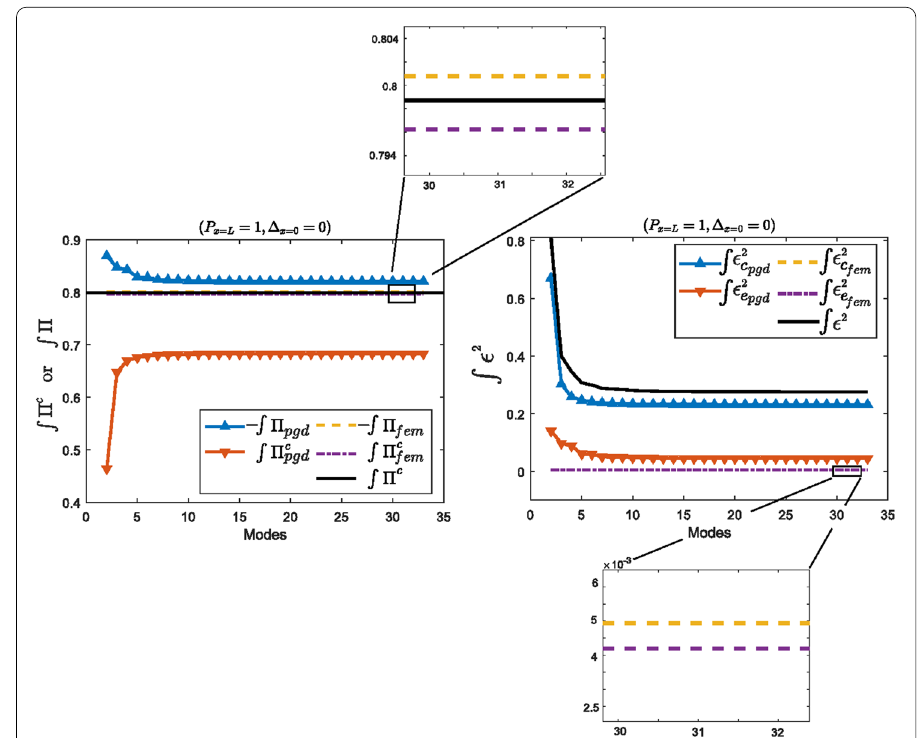
Fig. 5 Integral of the energies for both PGD and FEM